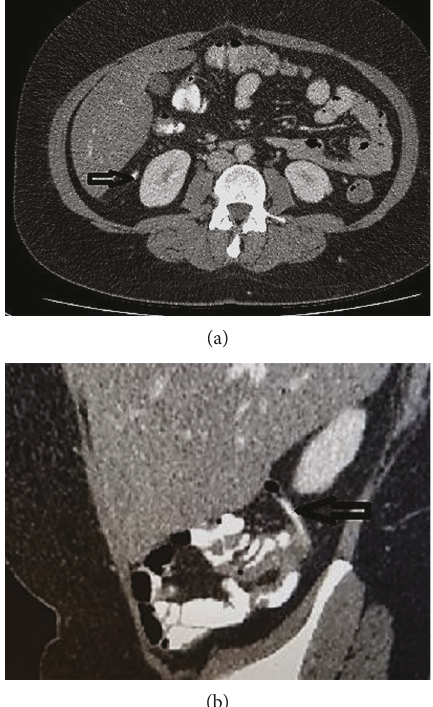
Figure 2: (a) Axial CT abdomen image and (b) sagittal image. The appendix looked entirely normal (horizontal arrows in (a) and (b)